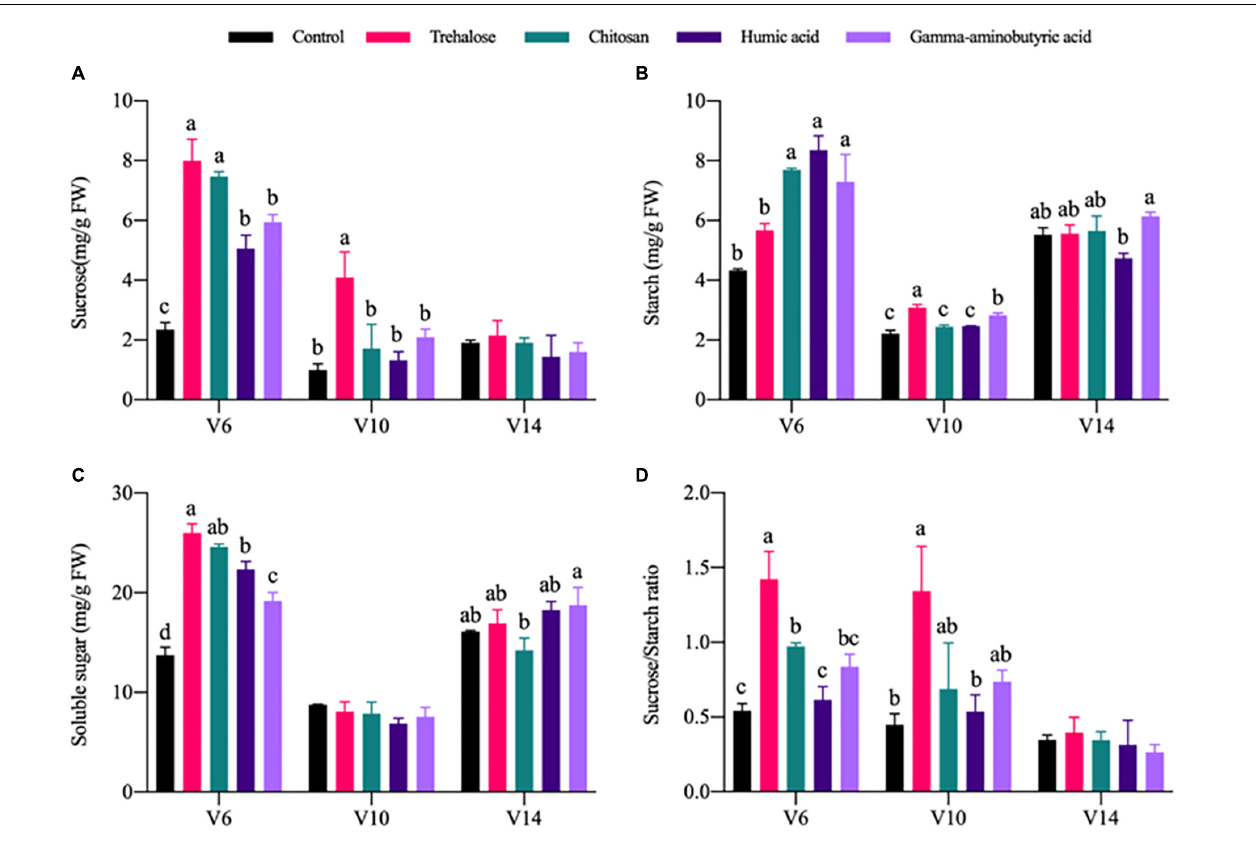
FIGURE 2 | Effects of PGRs on carbon metabolite accumulation in maize at different growth stages. Statistical analysis was used to compare differences in the mean among the PGR treatments shown in different colors. Treatments labeled with different lowercase letters were significantly different ( P < 0.05; n = 3), and the lack of such letters indicate no significant difference among treatments at each stage. V6, V10, and V14 represent the 6-, 10-, and 14-leaf stages of vegetative growth, respectively. FW, fresh weight. (A) Sucrose. (B) Starch. (C) Soluble sugar. (D) Sucrose/starch